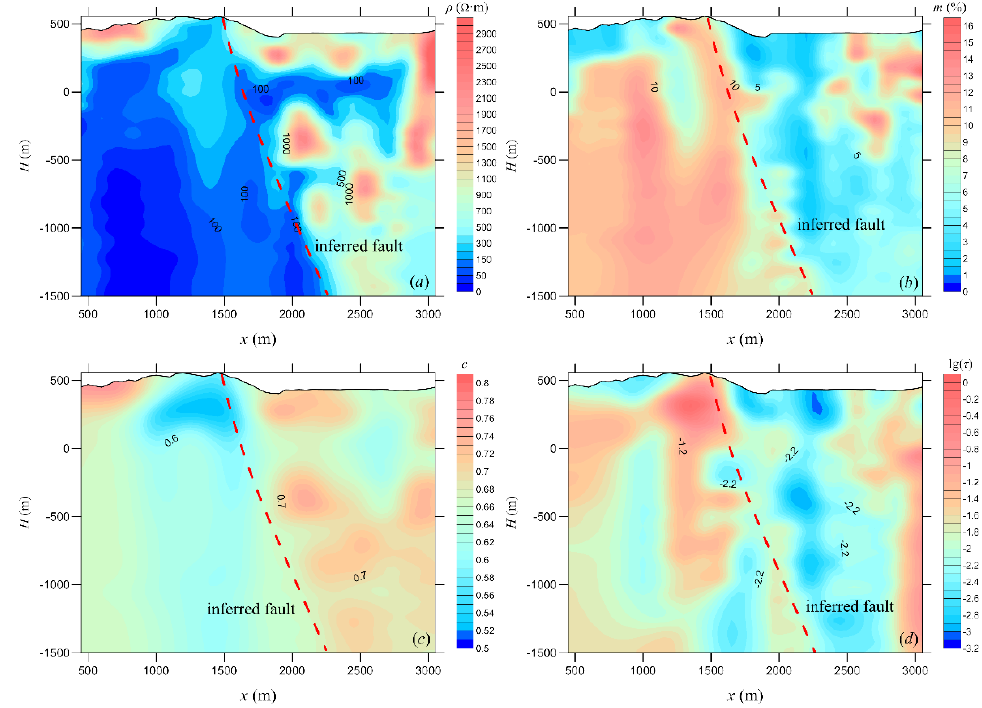
Figure 9. The inversion cross-sections. ( a ) The resistivity ; ( b ) The chargeability; ( c ) The frequency exponent; ( d ) The time constant.